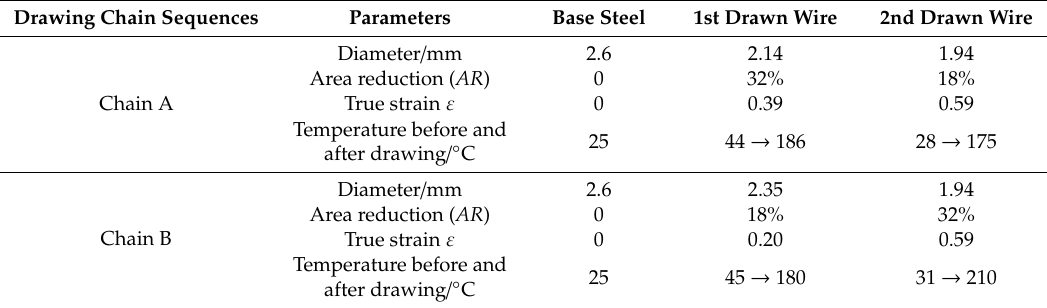
Table 2. Drawing chains with their deformation parameters and